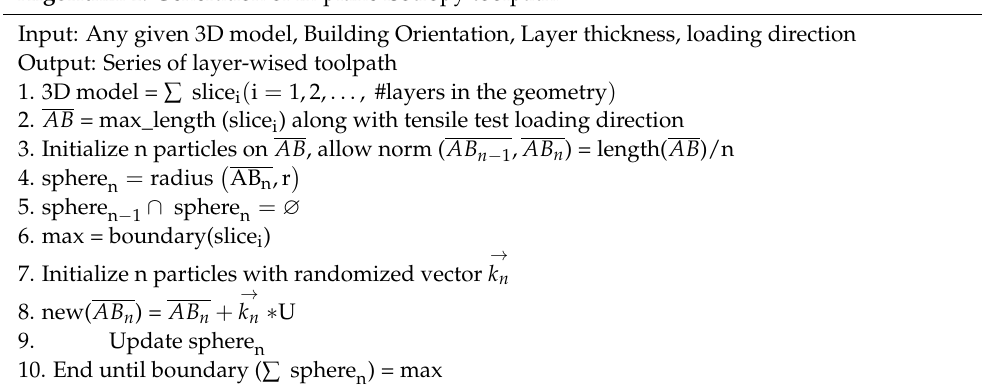
Algorithm 1: Generation of in-plane isotropy